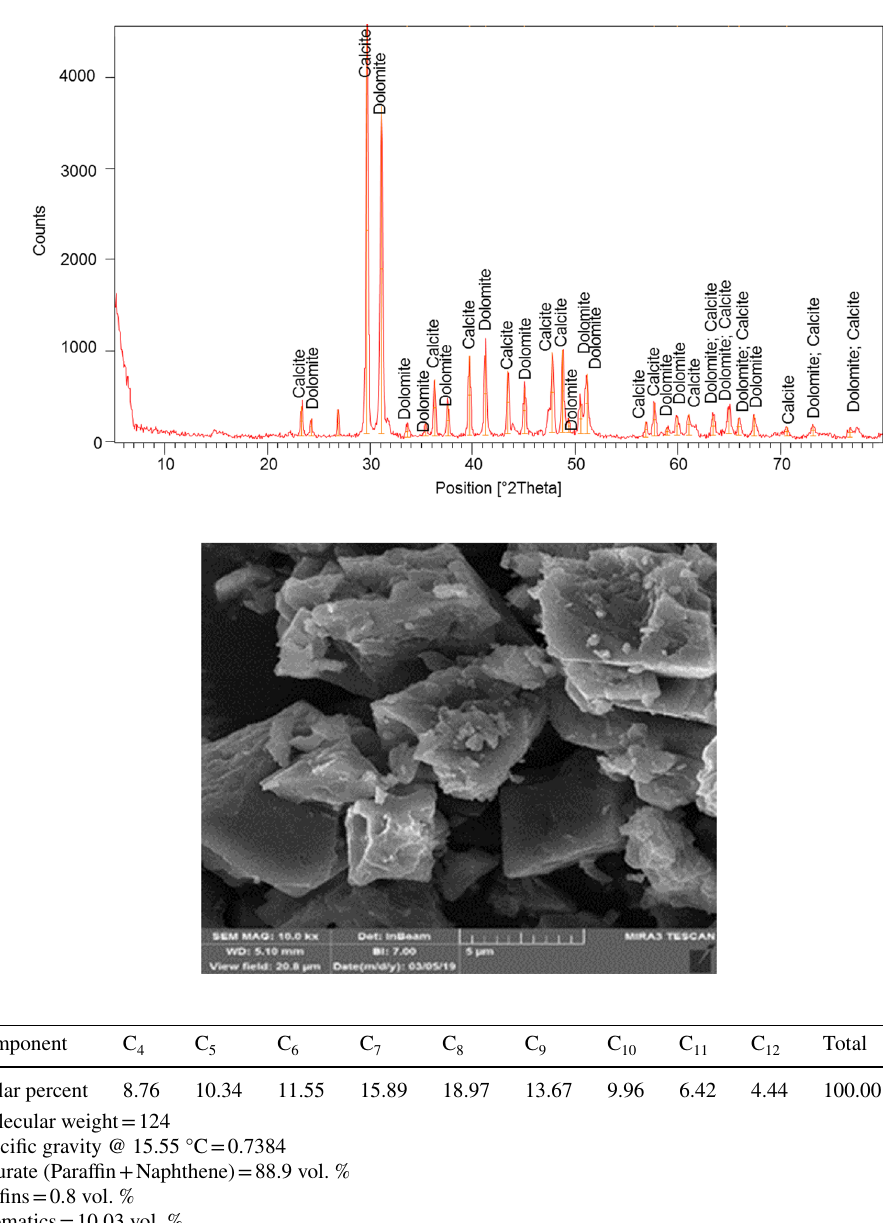
Fig. 1 XRD and SEM analyses of the used carbonate rock (Nowrouzi et al.